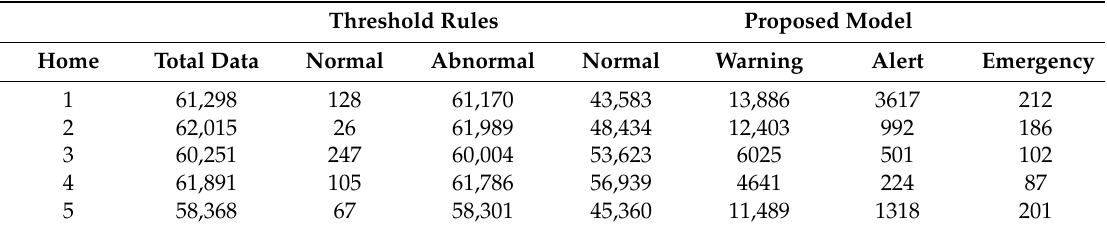
Table 7. Comparison between the proposed context-based model and threshold-based model.